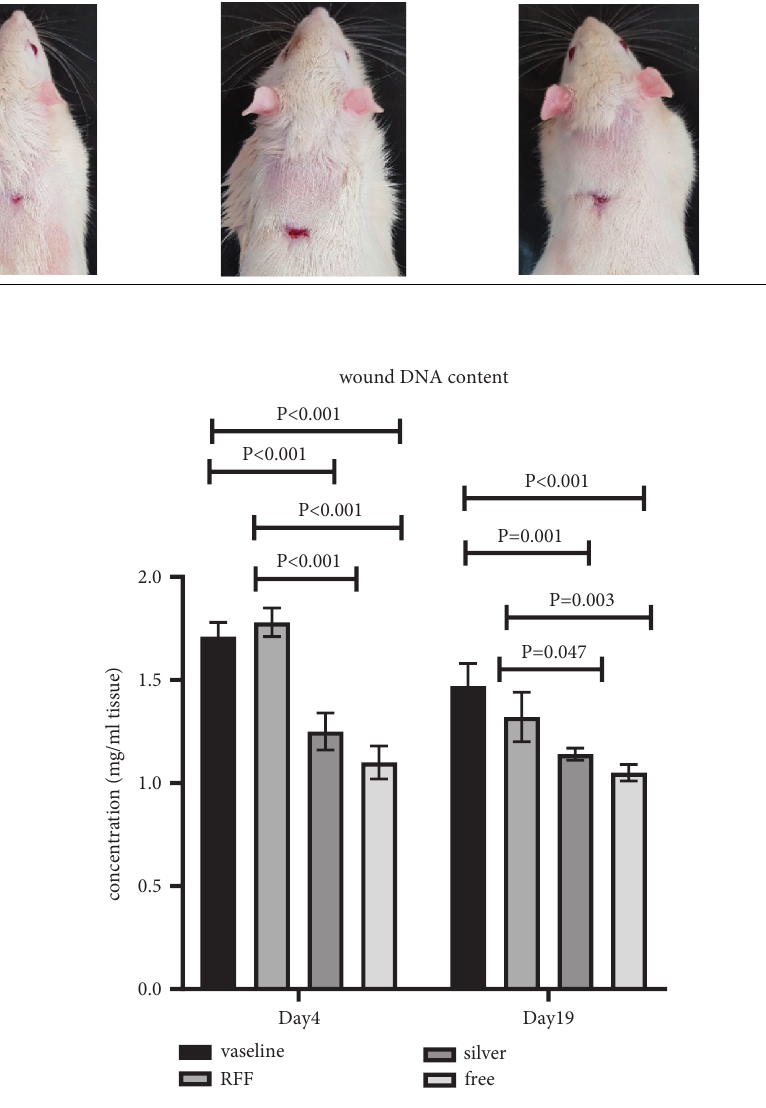
Figure 8: Total DNA evaluation between groups on days 4 and